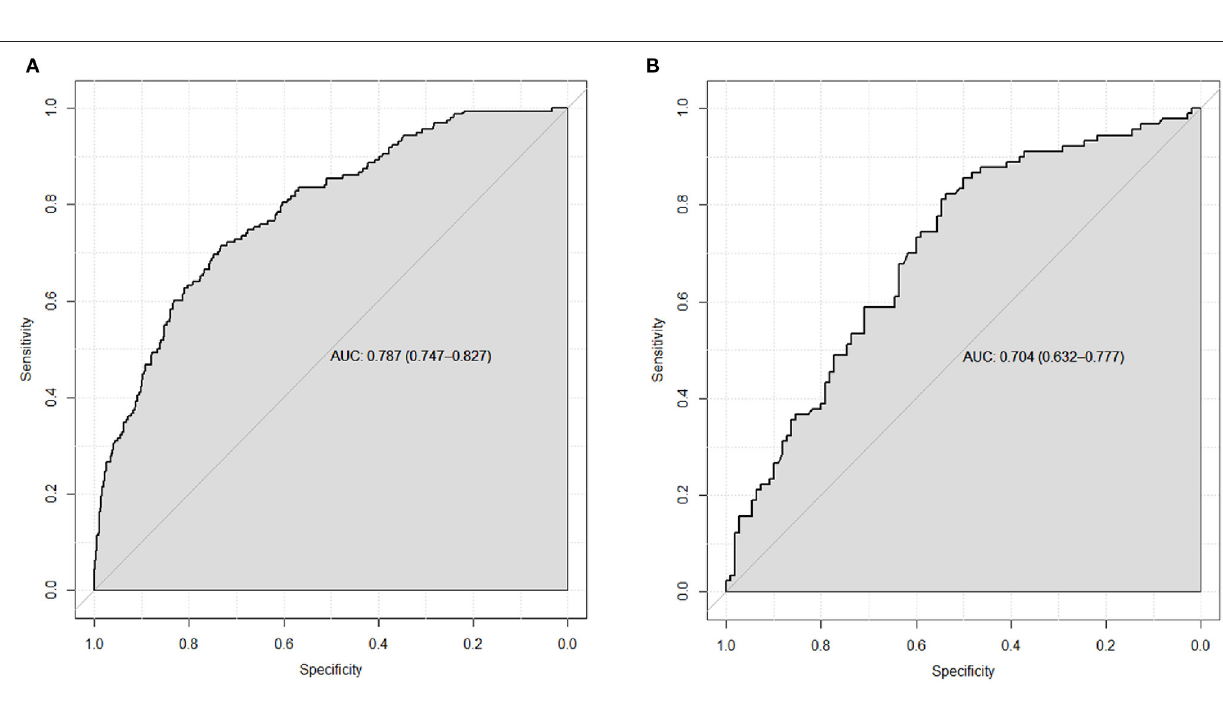
Frontiers in Public Health |